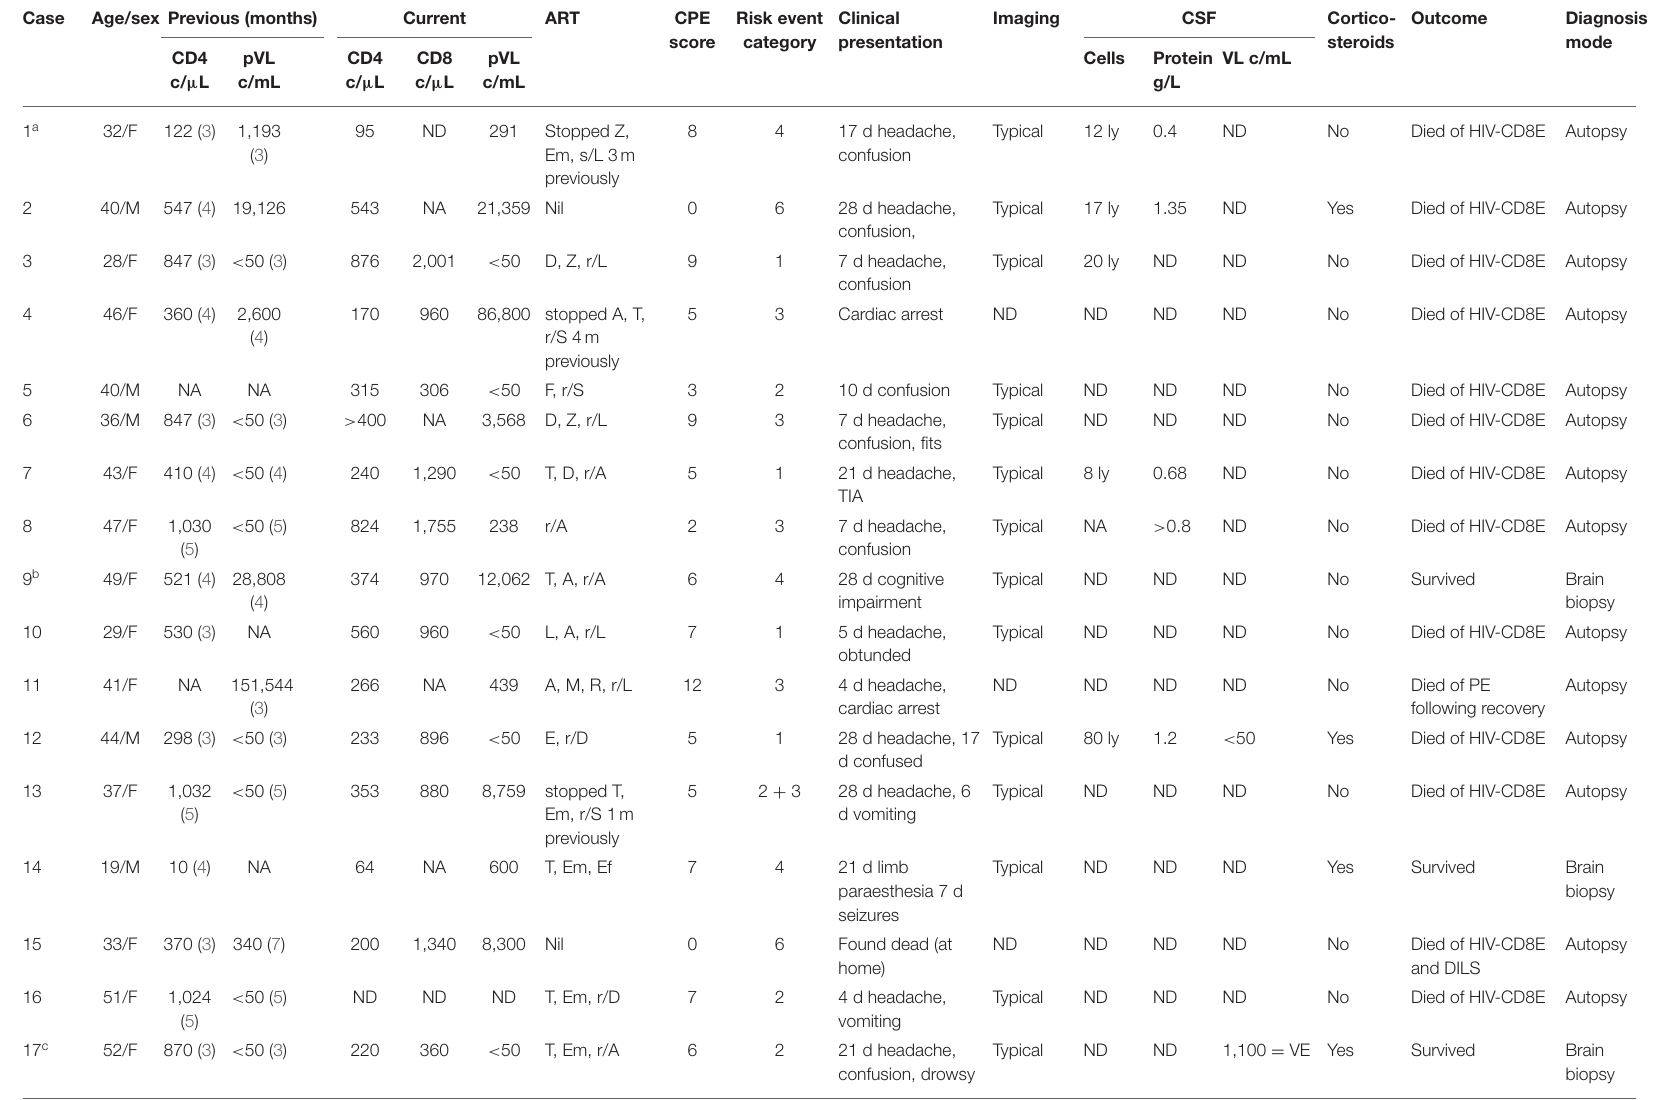
TABLE 1 | Twenty-three adults in UK with pathologically-confirmed HIV-associated CD8 encephalitis